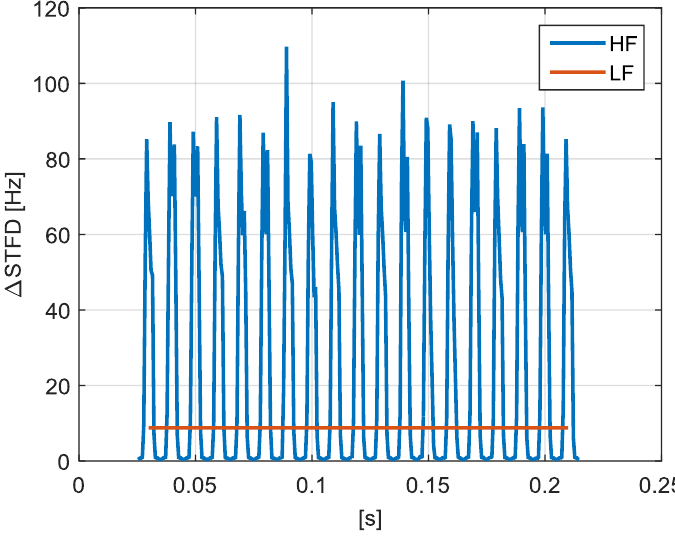
Figure 5. Case study 1: Δ STFD at low-frequency (0 ÷ 2 kHz, red line) and at high-frequency (2 ÷ 150 kHz, blue line) obtained by the instantaneous approach. Energies 2017 , 10 , 1633